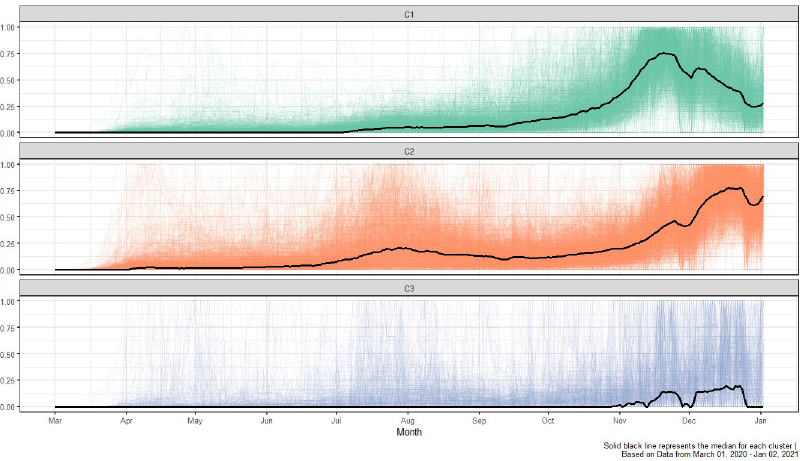
Fig 5. Map of the three scaled time-series profile clusters of COVID-19 cases by county in the contiguous United States.